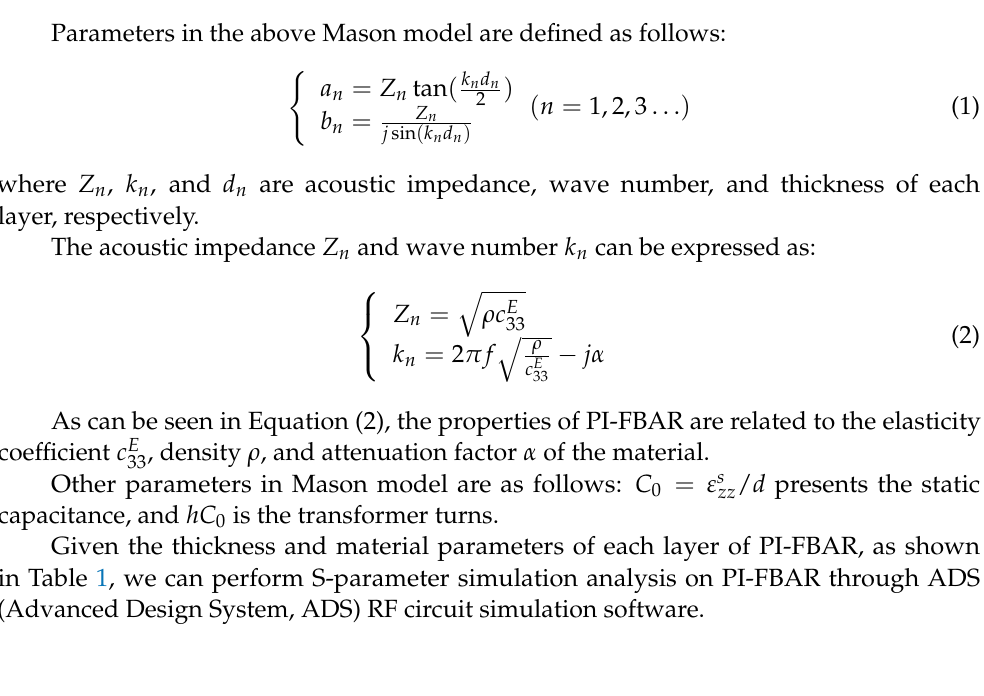
Figure 1. Mason equivalent transmission line model of PI-FBAR multilayer